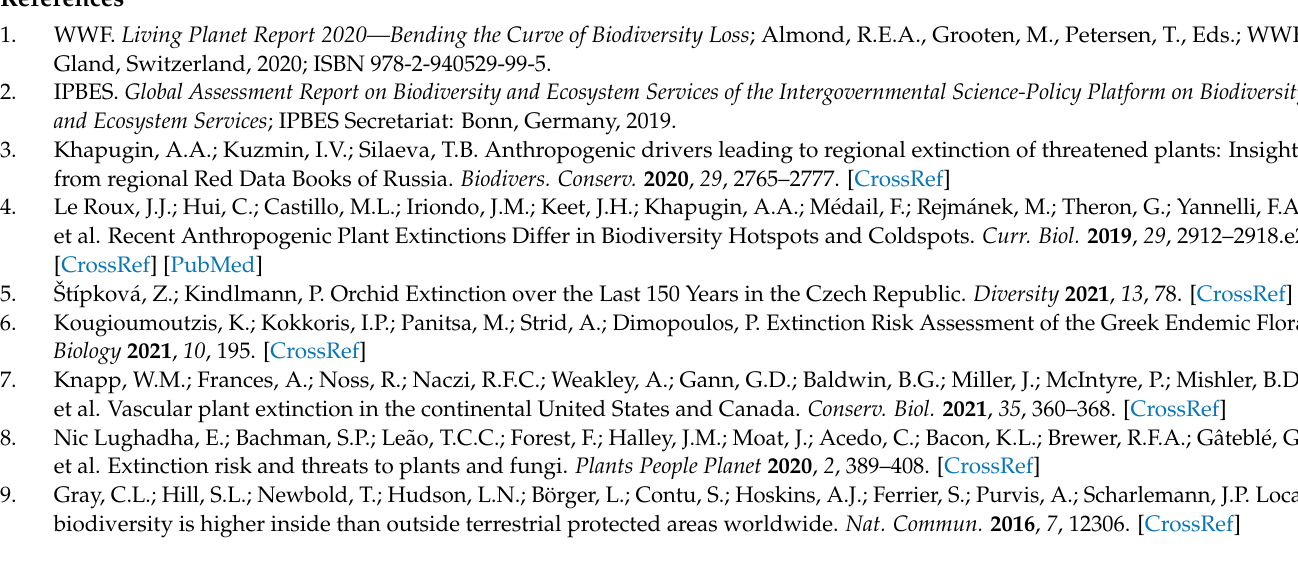
specific distribution models from MaxEnt; Table S1: Orchid species occurrence data; Table S2: Species presence/absence within PA network in Armenia; Table S3: Principal Component Analysis results; Table S4: AICc values for model selection using